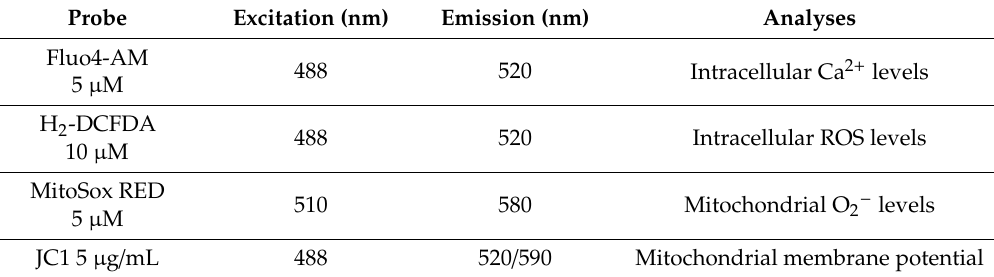
Table 2. Fluorescence probes used for intracellular